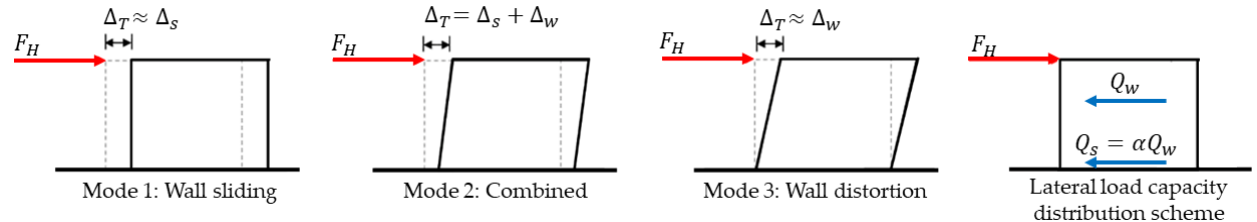
Figure 4. Single-story (M1 model) global failure modes and lateral load capacity distribution scheme.